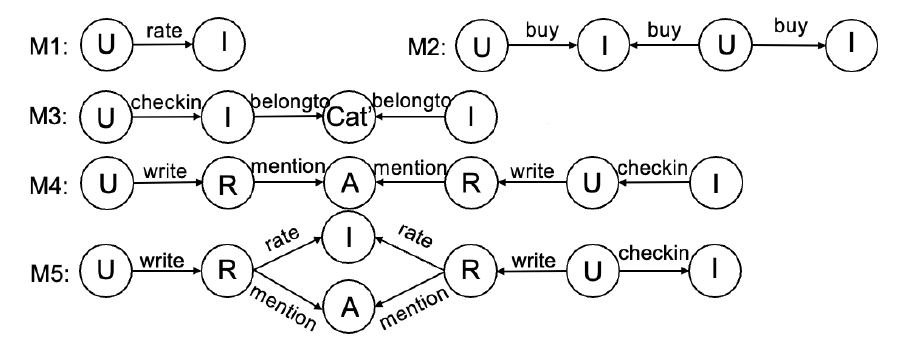
Figure 4. Metagraphs used in Amazon